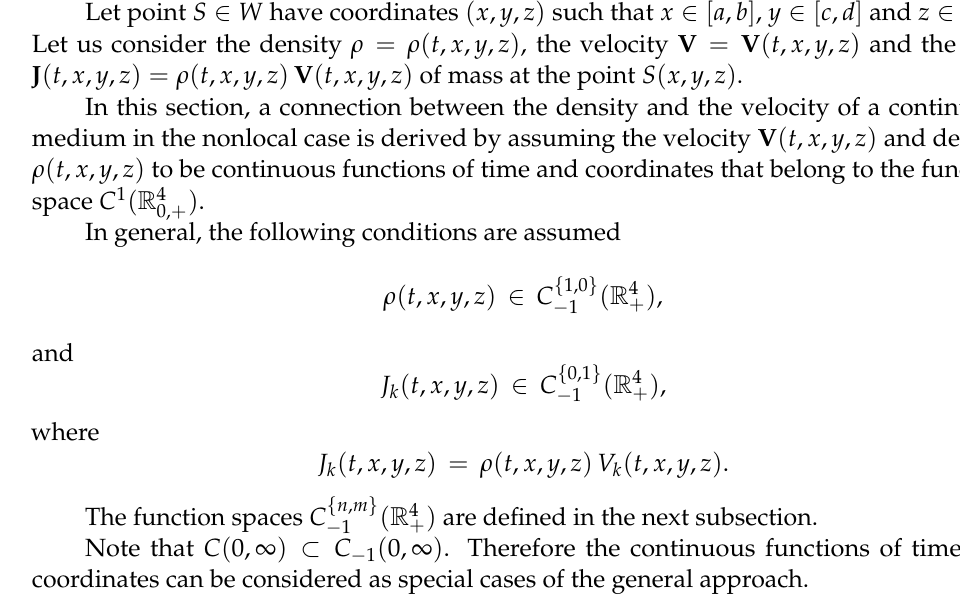
Figure 1: The elementary parallelepiped AB...C